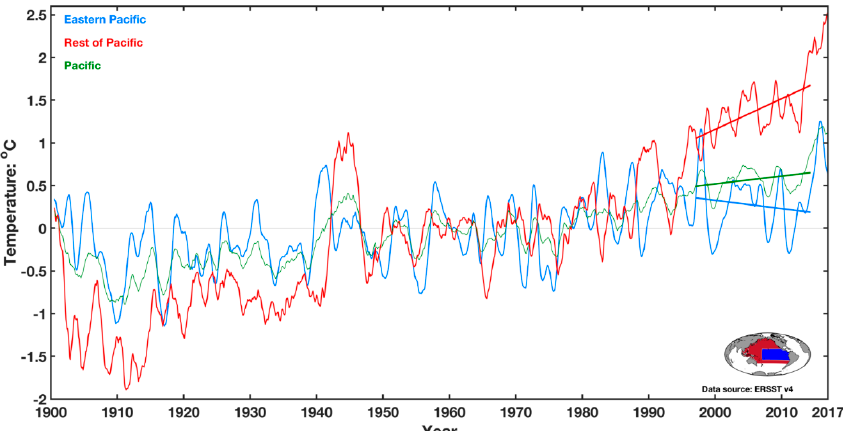
Figure 4. East vs. West Pacific SST (relative to 1961–1990 mean): The mean SST of the eastern tropical Pacific in blue curve (with weight = 1), and the mean SST of the rest of the Pacific (area weighted by 1.86). The mean SST for the Pacific basin as a whole is in green. The regions used are depicted in the inset. The blue region in the eastern Pacific is the same as that used in Kosaka and Xie [38] and is 35% of the Pacific basin. The SST time series have been smoothed using 27-month running mean. The linear trend, using the same color as the SST for each region, is objectively determined by least-square linear regression.